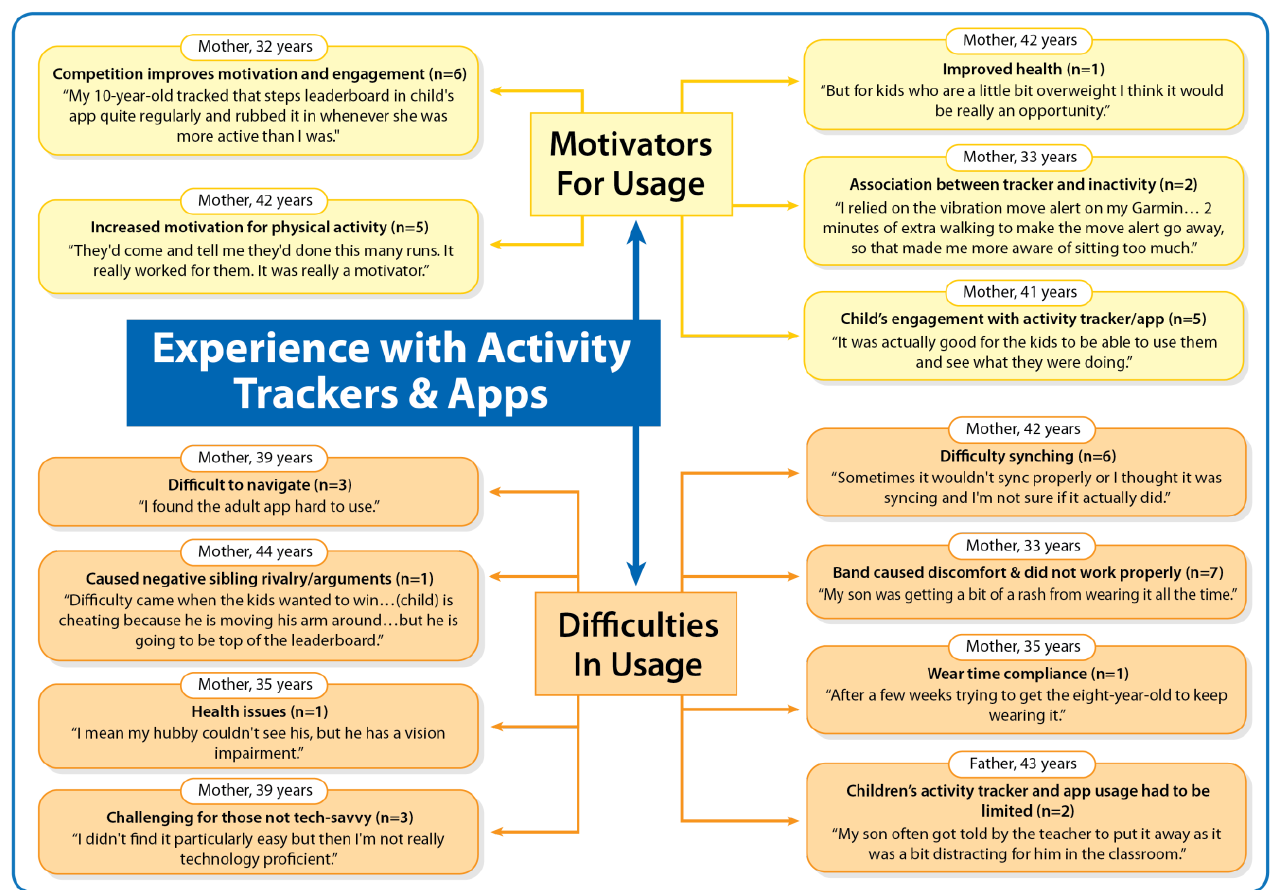
Figure 1. Families’ experience with the activity trackers and